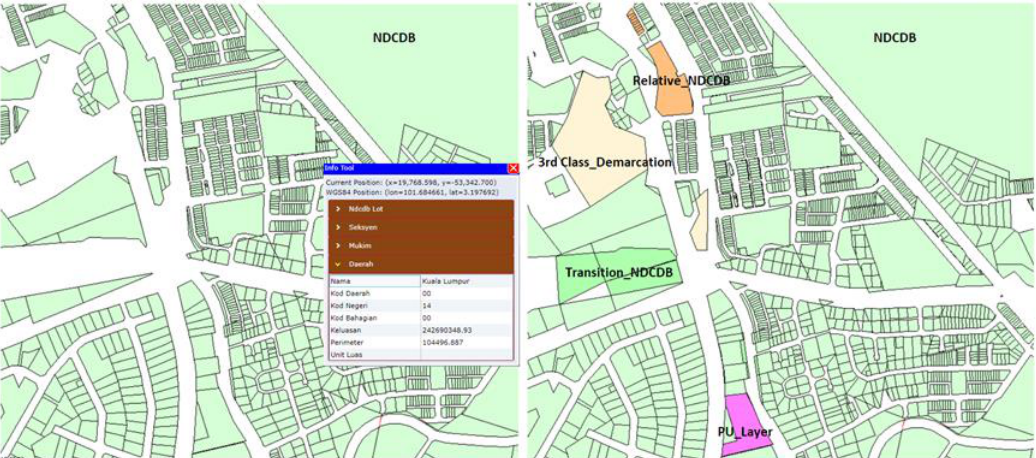
Figure 4: Sample of ‘Incomplete NDCDB’ (Left) vs ‘Completed NDCDB’ (Right) With Additional NDCDB